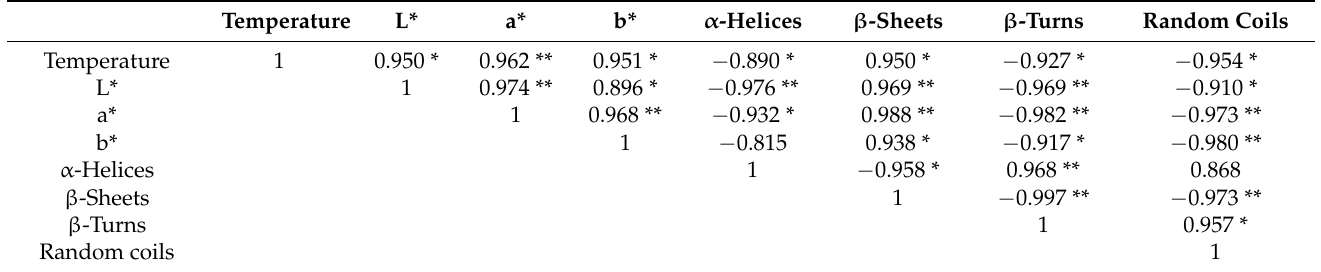
Table 3. Correlation analysis of heating temperature, secondary structures, and colour parameters of